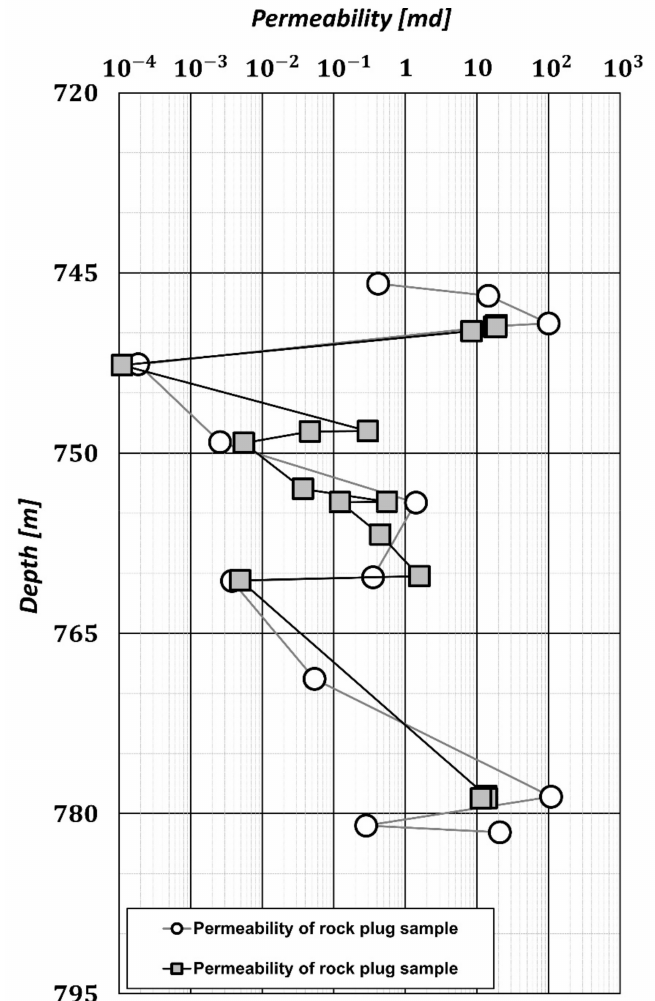
Figure 7. Measured vertical and horizontal permeabilities.